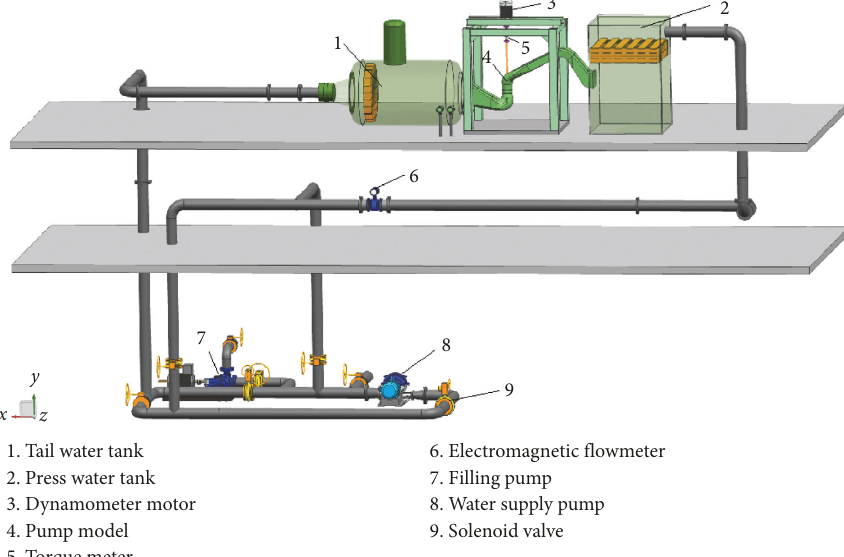
Figure 9: Hydraulic multifunction test bench. (1) Tail water tank; (2) press water tank; (3) dynamometer motor; (4) pump model; (5) torque meter; (6) electromagnetic flow meter; (7) filling pump; (8) water supply pump; (9) solenoid valve.